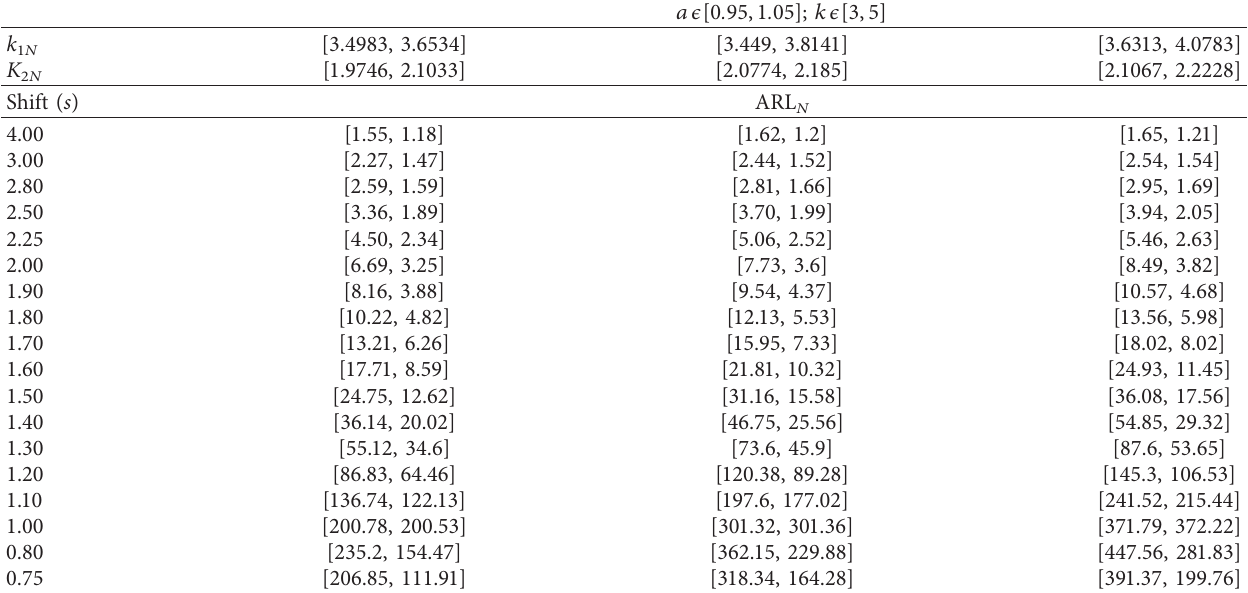
Table 3: The values of NARL when a � 0 . 95 and 1 . 05 and k � 3 and